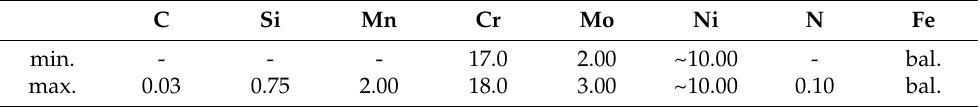
Table 8. Derived compositional range of 316L type stainless steel for PBF-LB/M processing in